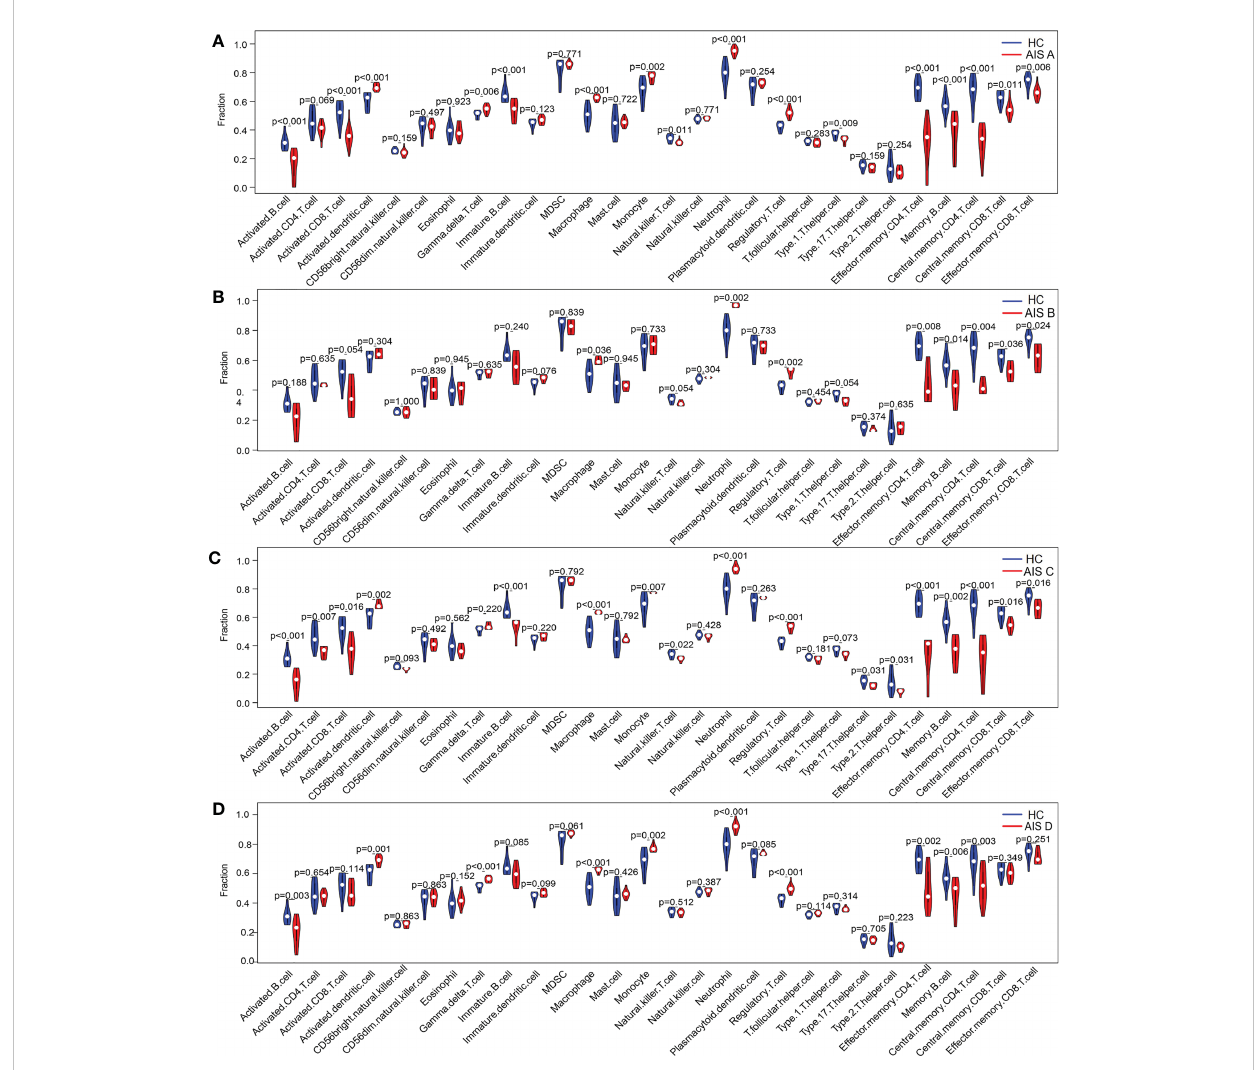
FIGURE 10 Differences in the content of immune cells between the SCI and HC groups analyzed using the ssGSEA algorithm. (A – D) Changes in immune cells in the blood of patients with SCI AIS A, AIS B, AIS C and AIS D grades using the ssGSEA algorithm. SCI, spinal cord injury; HC, healthy uninjured control; AIS, American Spinal Cord Injury Association Impairment Scale; ssGSEA, single-sample gene set enrichment